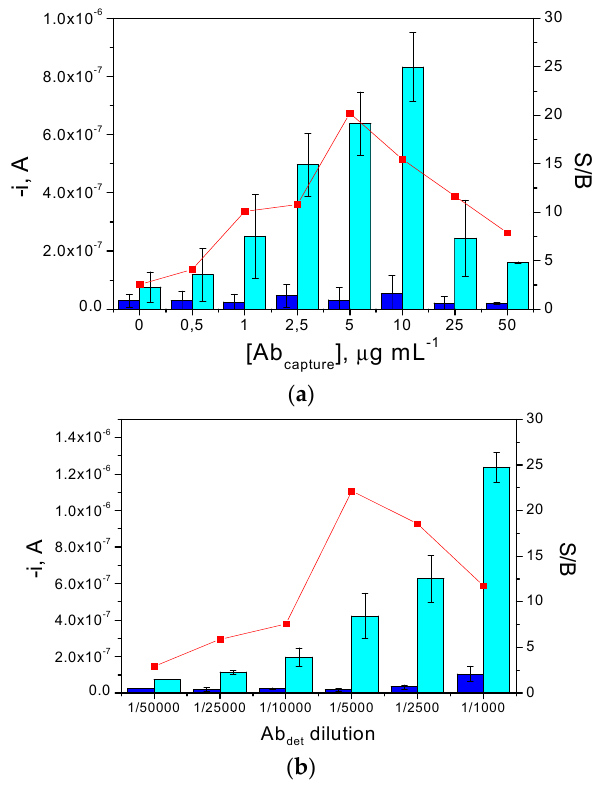
Figure 2. Dependence of the S/B current ratio (red ▪ ) with the AbC loading ( a ) and AbD dilution factor used to perform the immunoassay ( b ). Amperometric responses were measured for 0 (dark blue bars) and 100 ng·mL − 1 of human p53 standard (light blue bars). Error bars were estimated as triple that of the standard deviation ( n = 3).